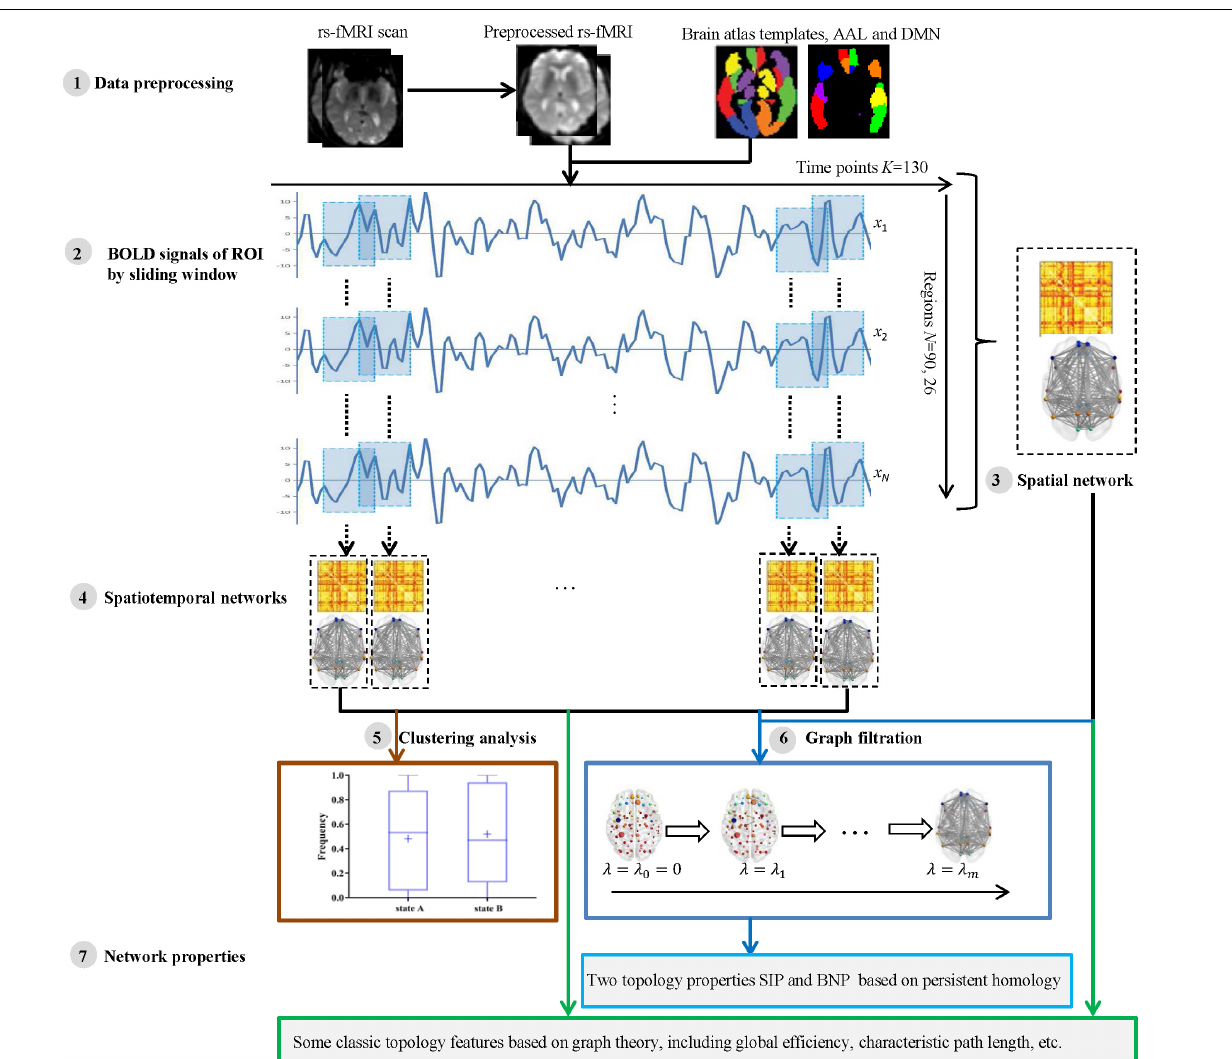
FIGURE 1 | The pipeline of measuring brain network topological structure based on graph theory and persistent homology using resting state functional MRI (rs-fMRI) data from Alzheimer’s Disease Neuroimaging Initiative